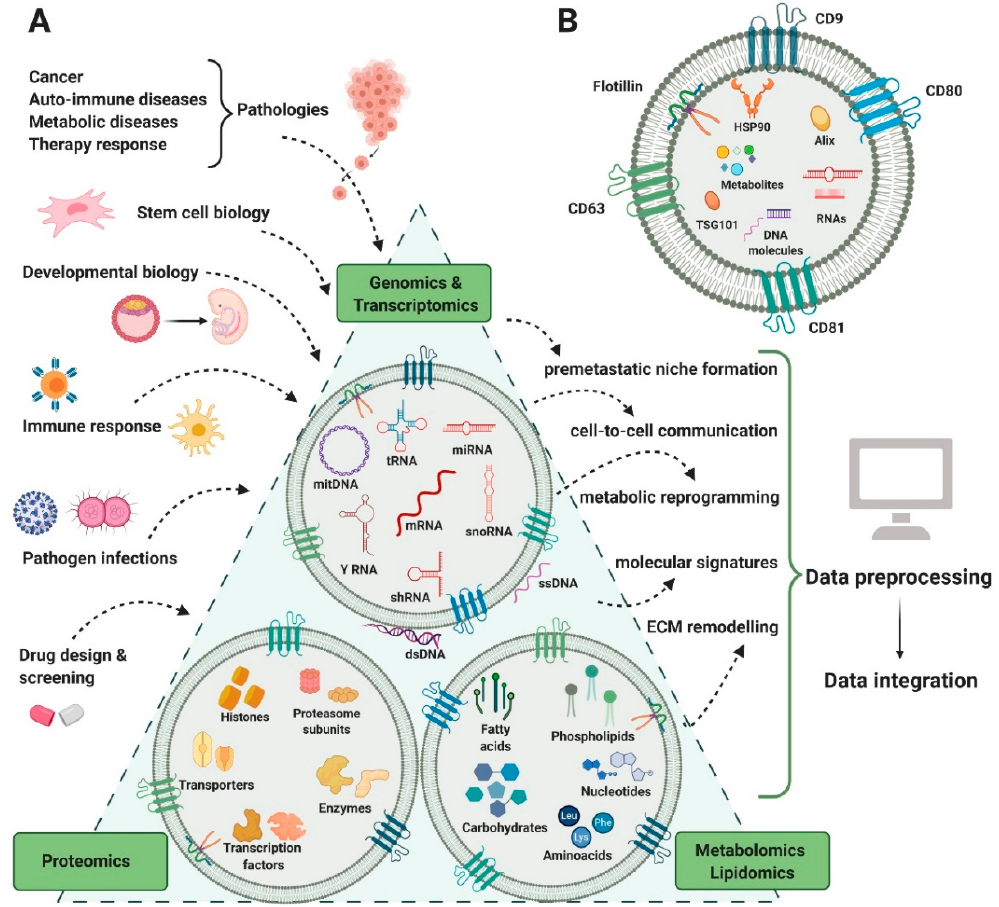
Figure 2. Correlation between EVs content in RNA, protein, lipid, and metabolites types and the multiple omics analyses that EV data integration can generate. Several areas of biology and medical research (input) generate complex genomics, transcriptomics, proteomics, lipidomics, and metabolomics analysis that can contribute to understanding several biological processes and functions (output). By means of bioinformatics tools, these data will be preprocessed and then integrated in order to answer various biological questions regarding intercellular communication ( A ). General structure of an EV, with specific EV markers—CD9, CD63, CD80, CD81, flotillin 1, Alix, and TSG101 ( B ). Figure created with BioRender.com.